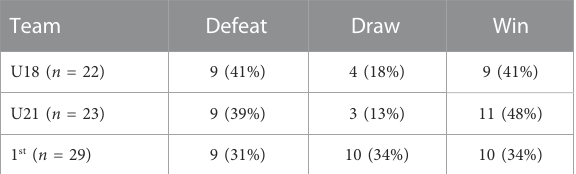
TABLE 4 Number of unique matches per team and match outcome. Data presented as n (%).